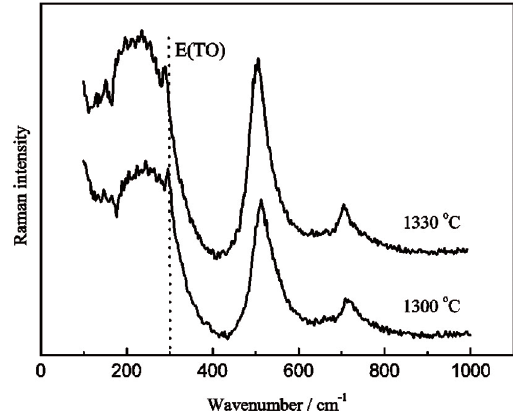
Figure 4: Room temperature depolarized Raman spectra for the samples.